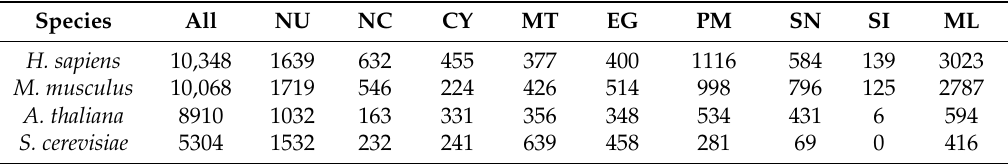
Table 1. Number of proteins in each subcellular